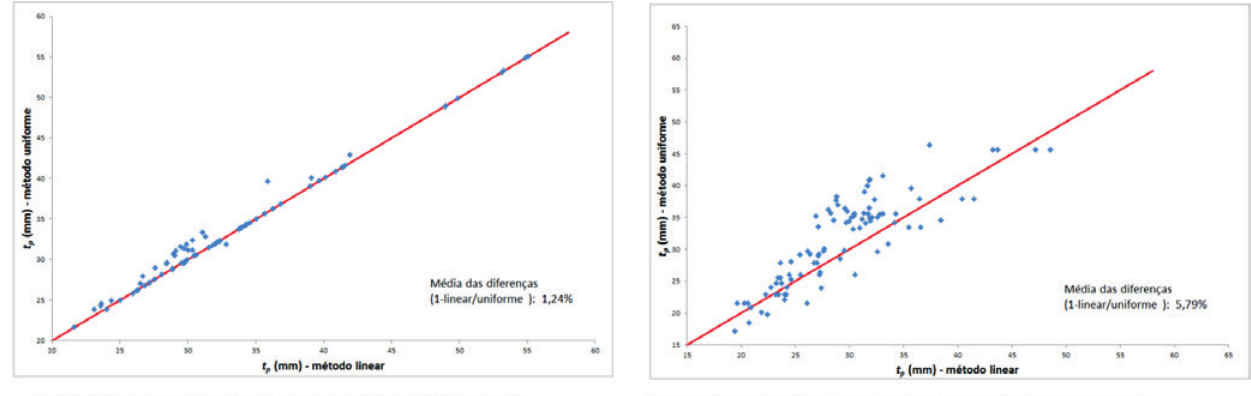
Gráfico da linha de ajuste perfeito para a espessura das placas de